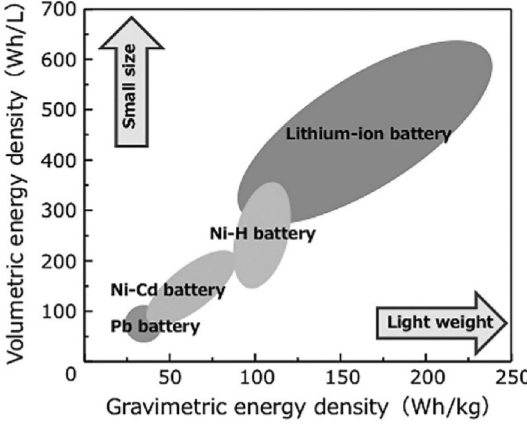
Fig. 1 Energy density diagram of different batteries